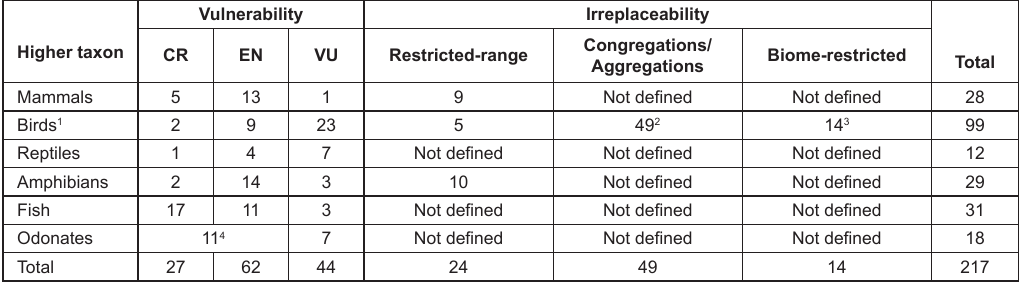
Table 2. Numbers of species triggering each of the criteria/subcriteria for each higher taxonomic group